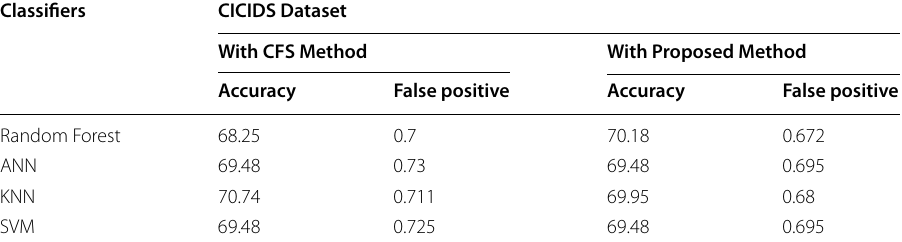
Table 21 Results of CFS method and proposed method on CICIDS dataset Classifiers